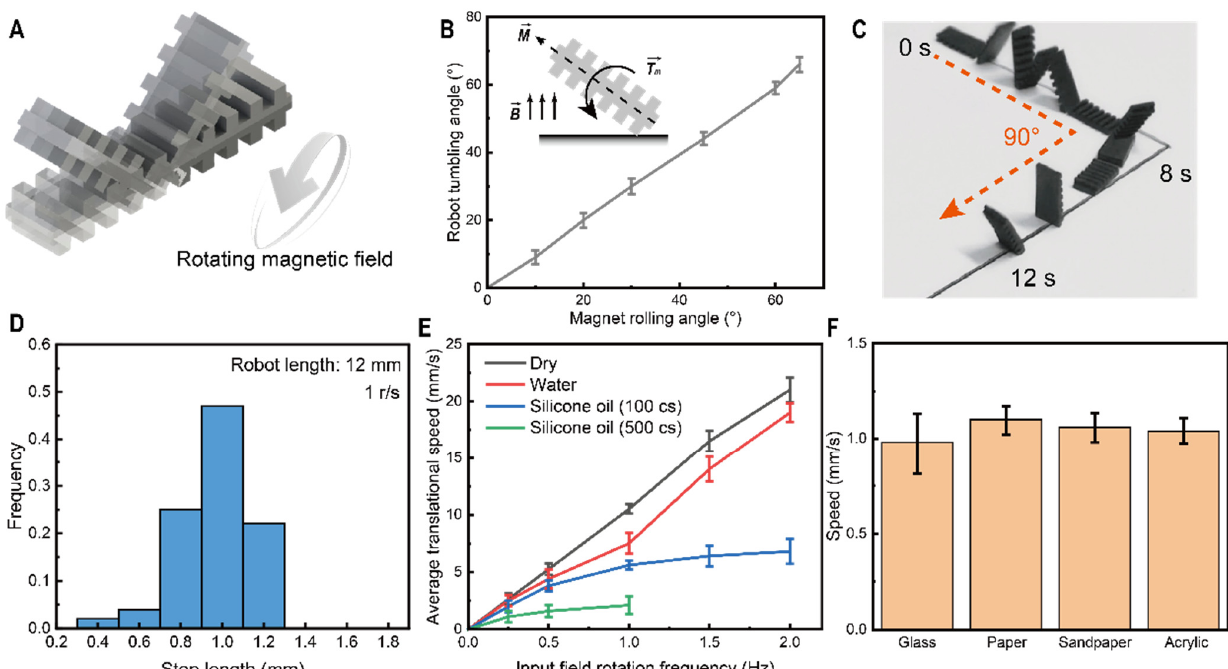
Figure 2. Soft robot with a tumbling-based linear motion. ( A ) Soft robot tumbling motion driven by rotating magnetic fields. ( B ) Relationship between the magnetic field angle and robot rotation angle. ( C ) Fast movement and turning capability of the soft robot. ( D ) Frequency diagram of the soft robot step distribution in a rotating magnetic field at 1 r/s. ( E ) Relationship between the speed of the soft robot movement and the magnetic field speed on substrate surfaces coated with different materials. ( F ) Average rate of movement of soft robots on different substrate surfaces.